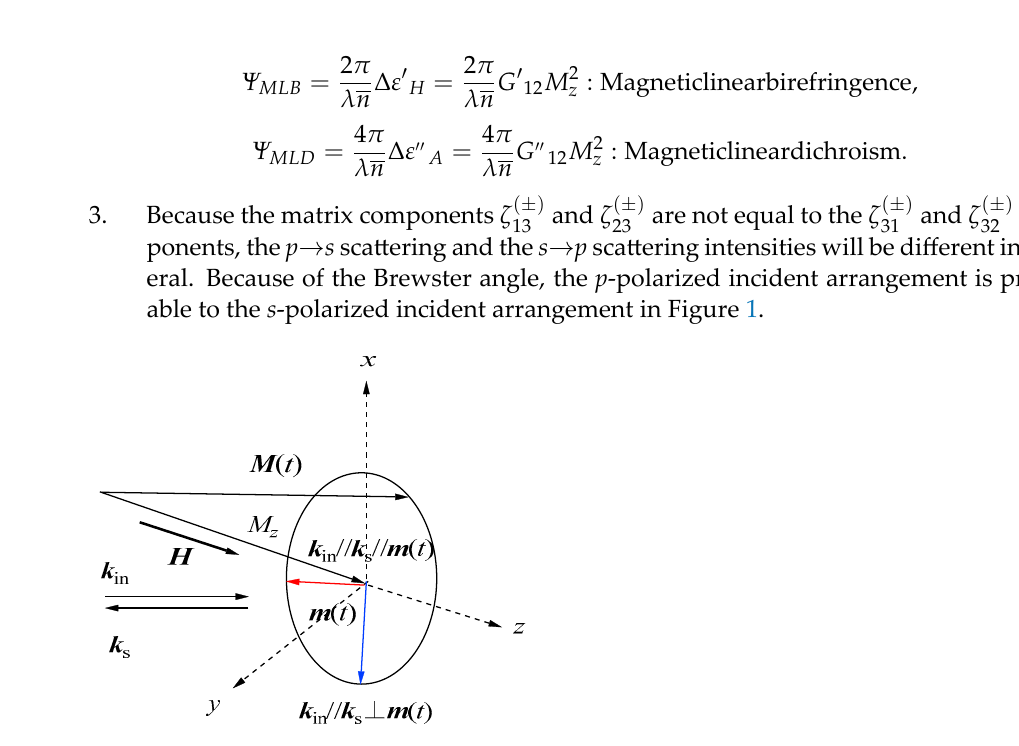
Figure 2. Schematic illustration of the precession motion of the magnetic moment and scattering geometry. It shows that two magneto-optical geometries take place during a cycle of precession motion.